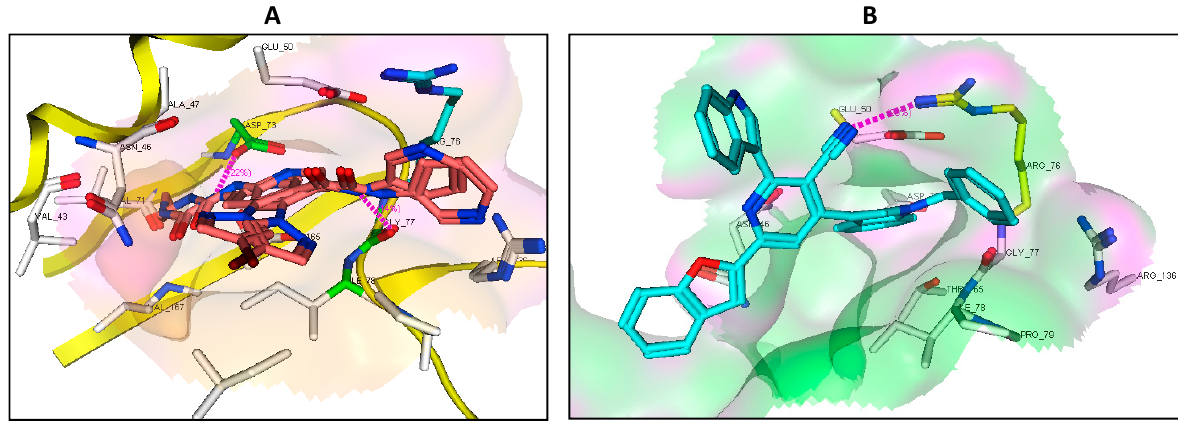
Figure 7. ( A ) The binding mode of the re-docked ligand within the binding pocket of DNA gyrase B (ID: 6F86 ). The re- docked ligand shows superimposed on the same position as the native ligand (brown, stick) with the same orientation. The two ligands show the same H-bonds profile with Asp73 and Gly77 (green, stick). The re-docked ligand shows hydrophobic interaction with Arg76 (cyan, stick); ( B ) The binding mode of compound 7c (cyan, stick) within the binding pocket of DNA gyrase B (ID: 6F86 ) with one H-bond acceptor to Arg76 (yellow,